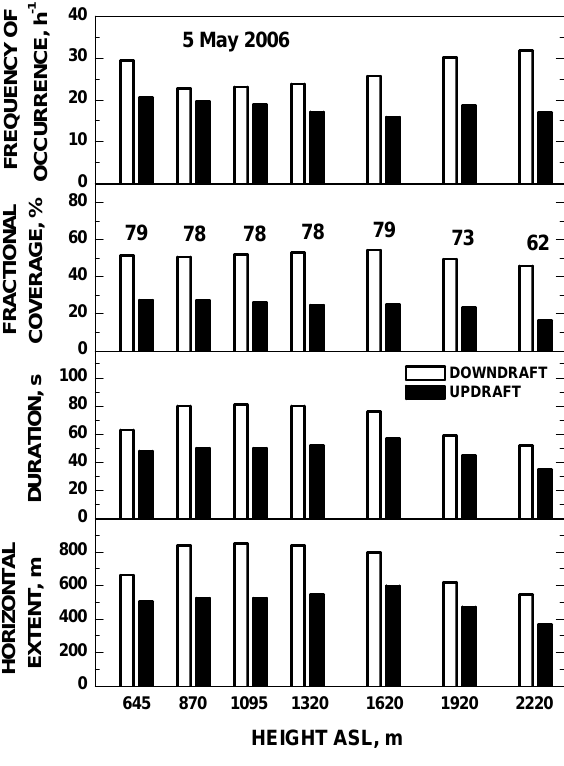
Fig. 6. Mean frequency of occurrence, fractional coverage of up and downdrafts (defined by Eq. (1) and Eq. (2)), mean occurrence dura- tion of the up- and downdrafts, and corresponding mean horizontal extent according to mean horizontal wind speed of 4.2m/s. Statis- tics are separately shown for updrafts (black columns) and down- drafts (white columns) for heights a.s.l. of 645, 870, 1095, 1320, and 1620m and for time periods during which vertical velocities could continuously be measured within the entire observational pe- riod from 09:49 and 16:45LT (07:49–14:45UTC) on 5 April 2006.